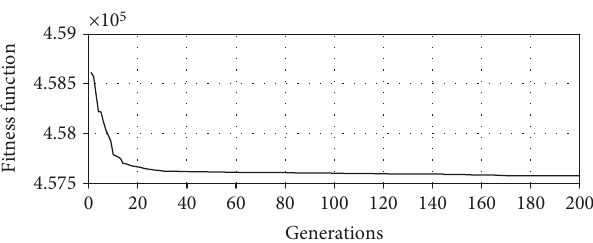
Figure 21: Evolution of the fi tness function of strategy 6 through